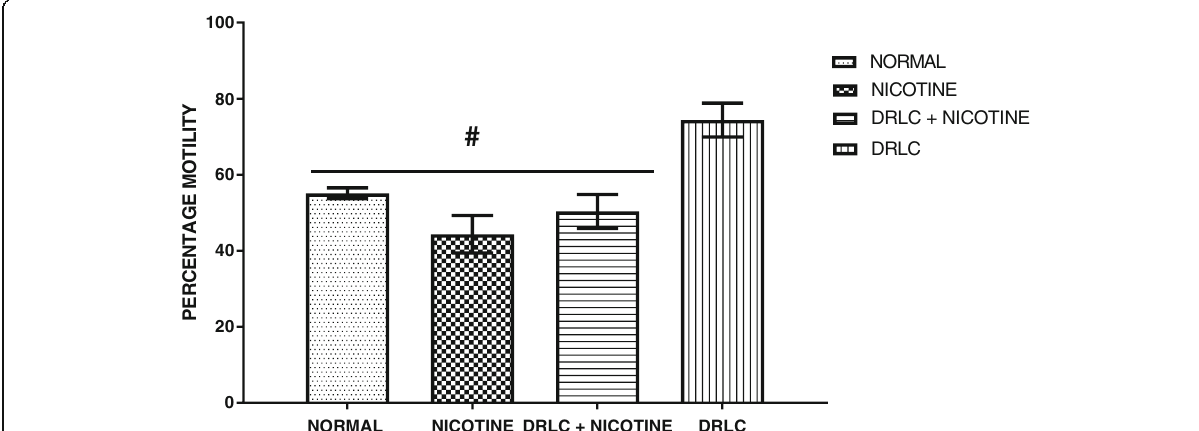
Fig. 10 Chart showing the percentage sperm motility of the experimental animals. Values are mean ± SEM. N = 5. # Statistically different from DRLC group, p <